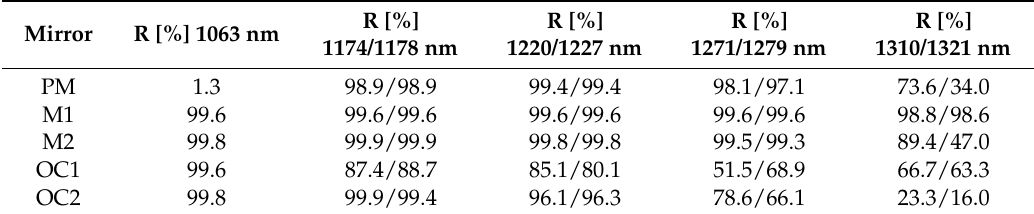
Table 2. Raman laser cavity mirrors reflectivities at pumping and Stokes